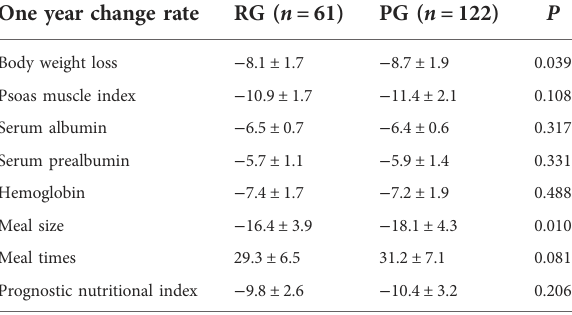
TABLE 7 One year change rate of nutrition-related indexes after operation.